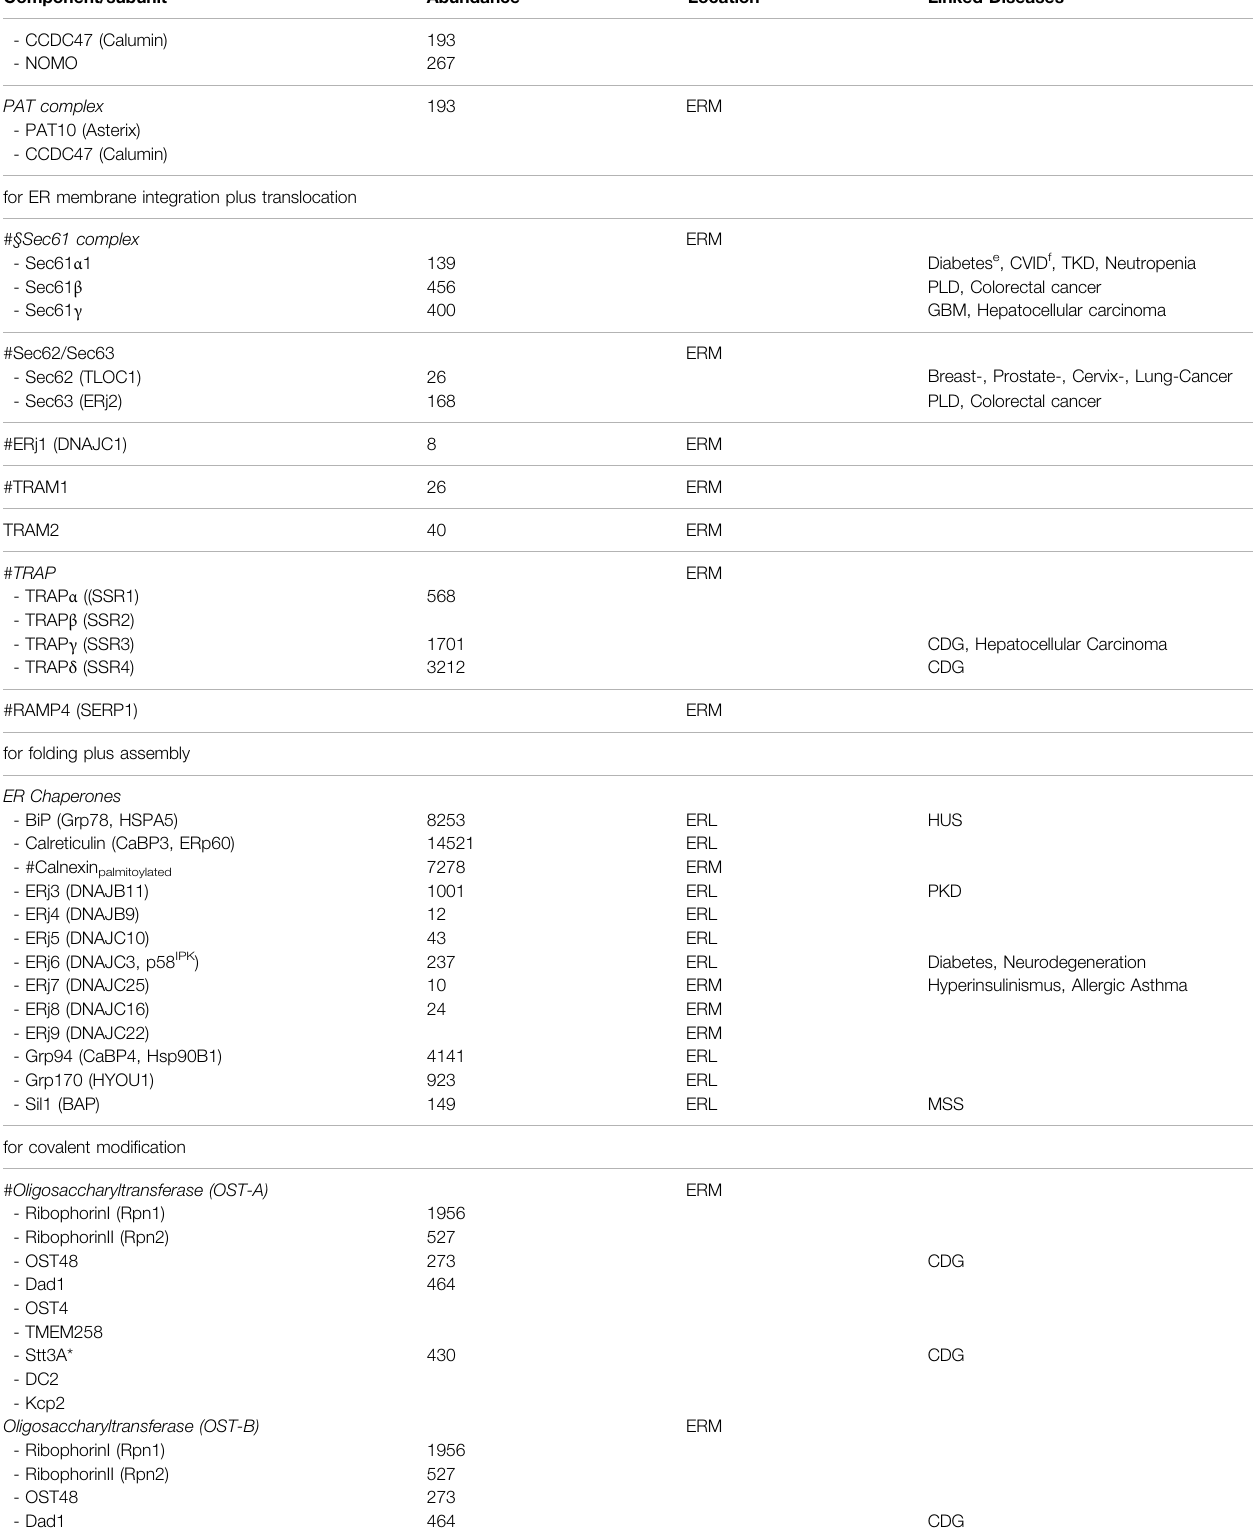
TABLE 1 | ( Continued ) Protein transport components/ complexes, associated proteins in HeLa cells and linked